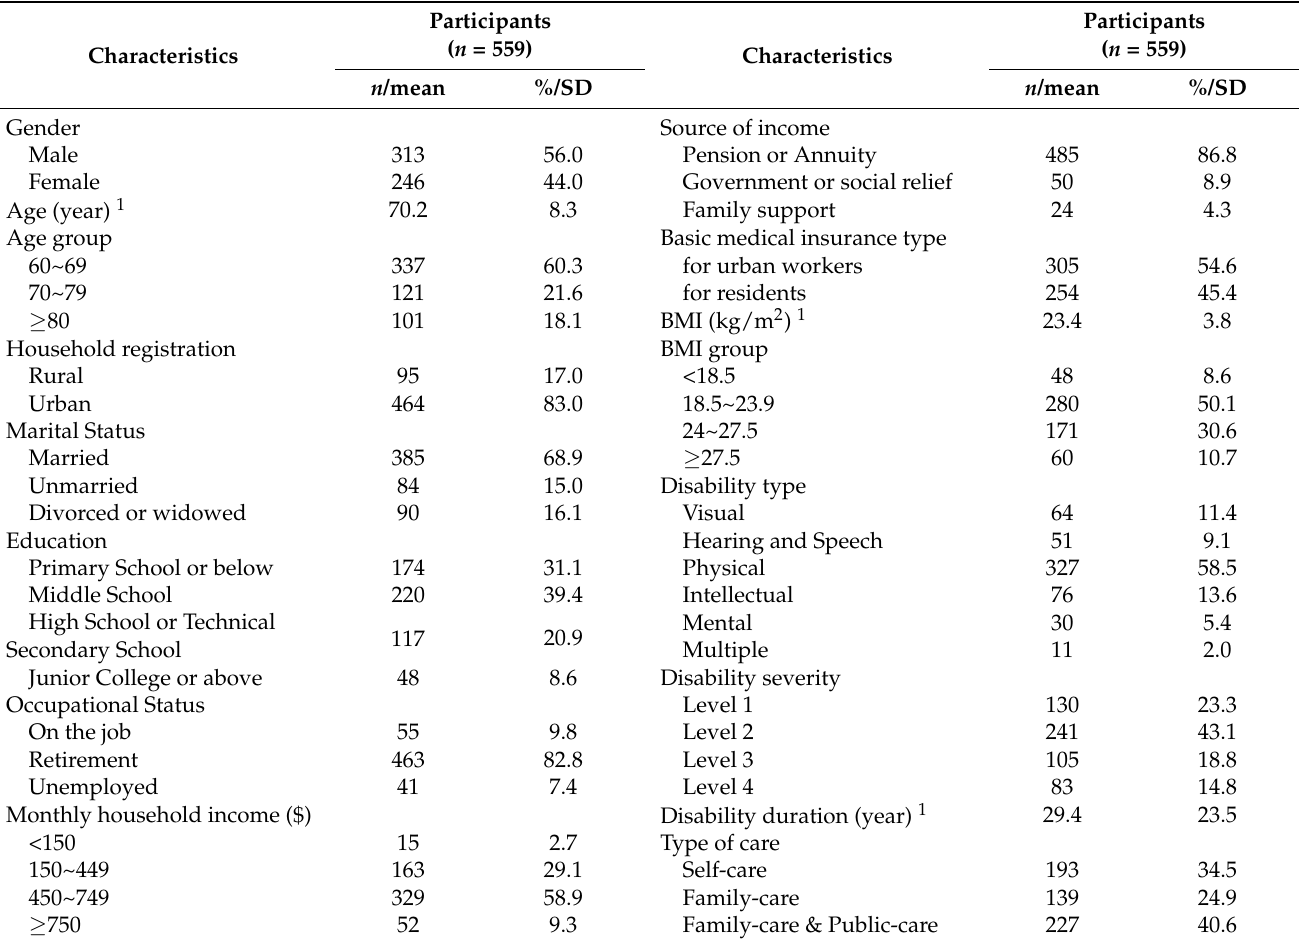
Table 1. Basic characteristics of the disabled